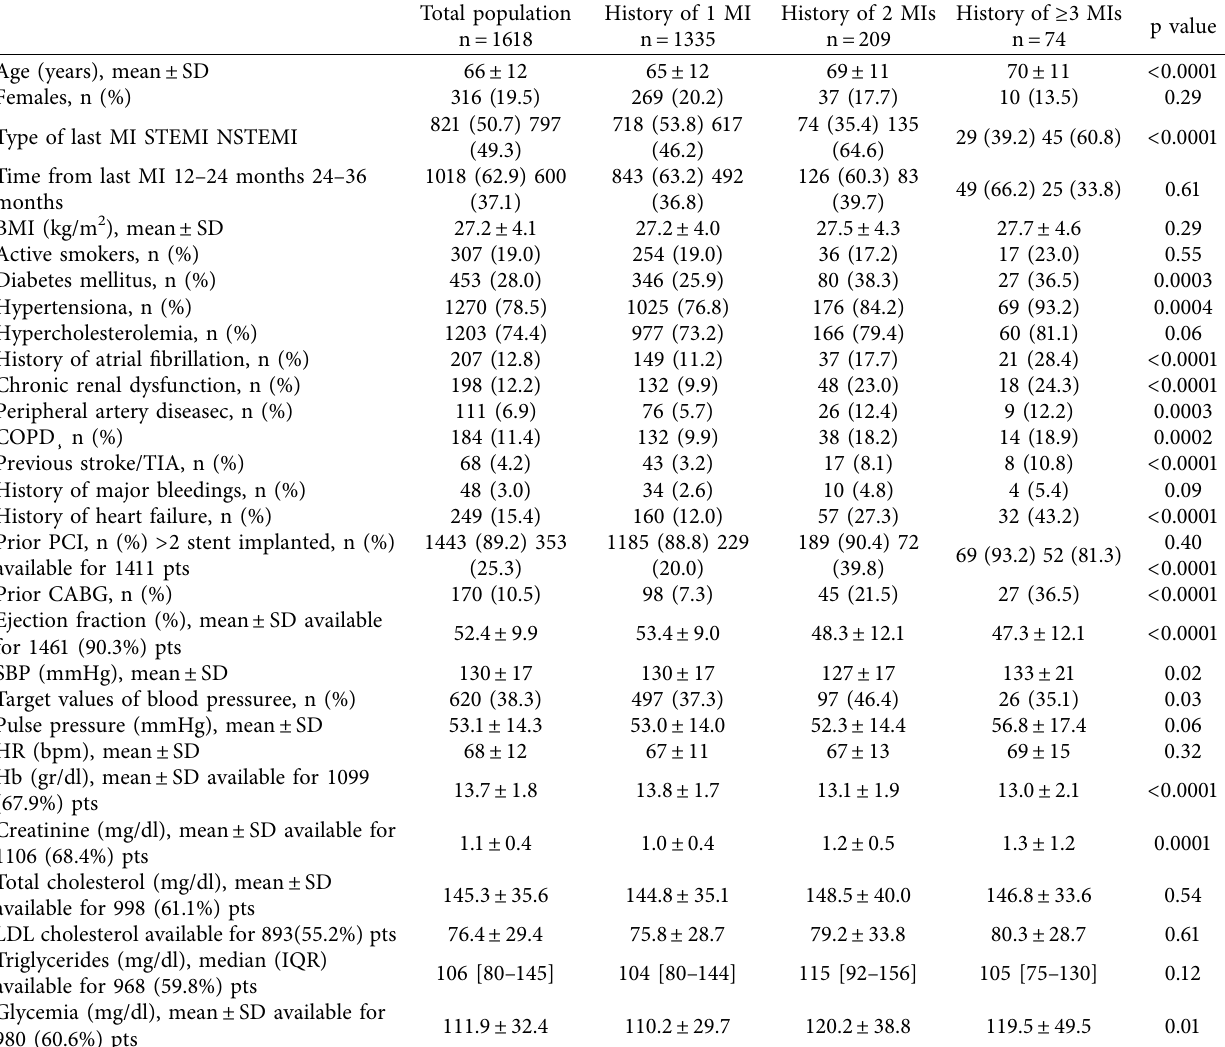
Table 1: Baseline clinical characteristics, hemodynamic, and laboratory variables of patients presenting with a history of 1, 2, or ≥ 3